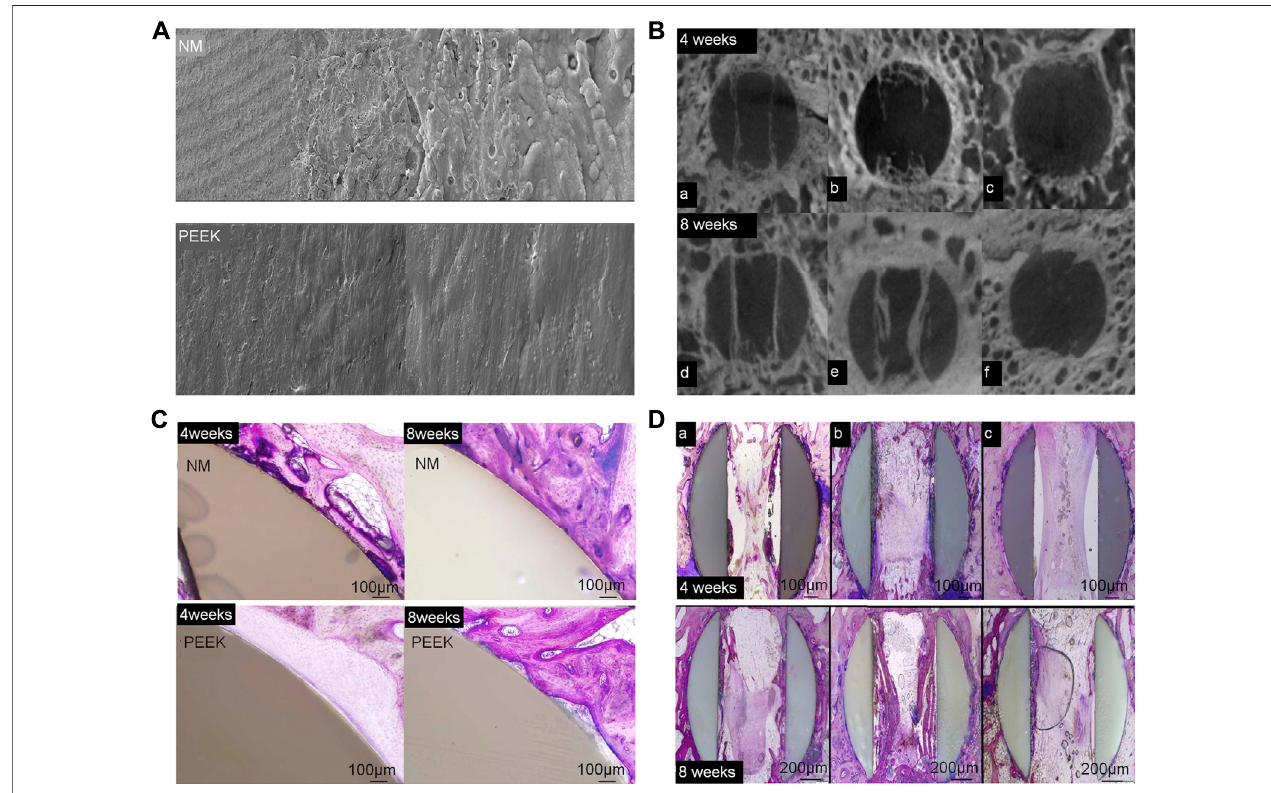
FIGURE 6 | (A) Scanning electron microscopy was used to examine the surface topography of NanoMetalene (NM) and PEEK at magni fi cations of ×500, 5,000×, 20,000×, and 50,000×. (B) Micro-CT image reconstructions in the middle of an aperture at 4and 8 weeks in the sagittal plane for each group. Group 1was coated with NMonallsurfaces,Group2hadaNMcoatinginsidetheapertureswithaPEEKoutside,andGroup3hadPEEKwithnocoating. (C) Atypicalhigher-magni fi cationvisual of the outside of the NM-coated surface and PEEK implants at 4 and 8 weeks. Direct bone contact with the Ti coating with NM occurred at 4 weeks, which improvedovertimeto8 weeks.PEEKsurfacespresentedatypicalnon-reactive fi broustissueinterfaceat4 weeks,withsomefocalbonecontactat8weeks. (D) PMMA histology in the middle of the apertures at 4 and 8 weeks in the sagittal plane (Walsh et al.,